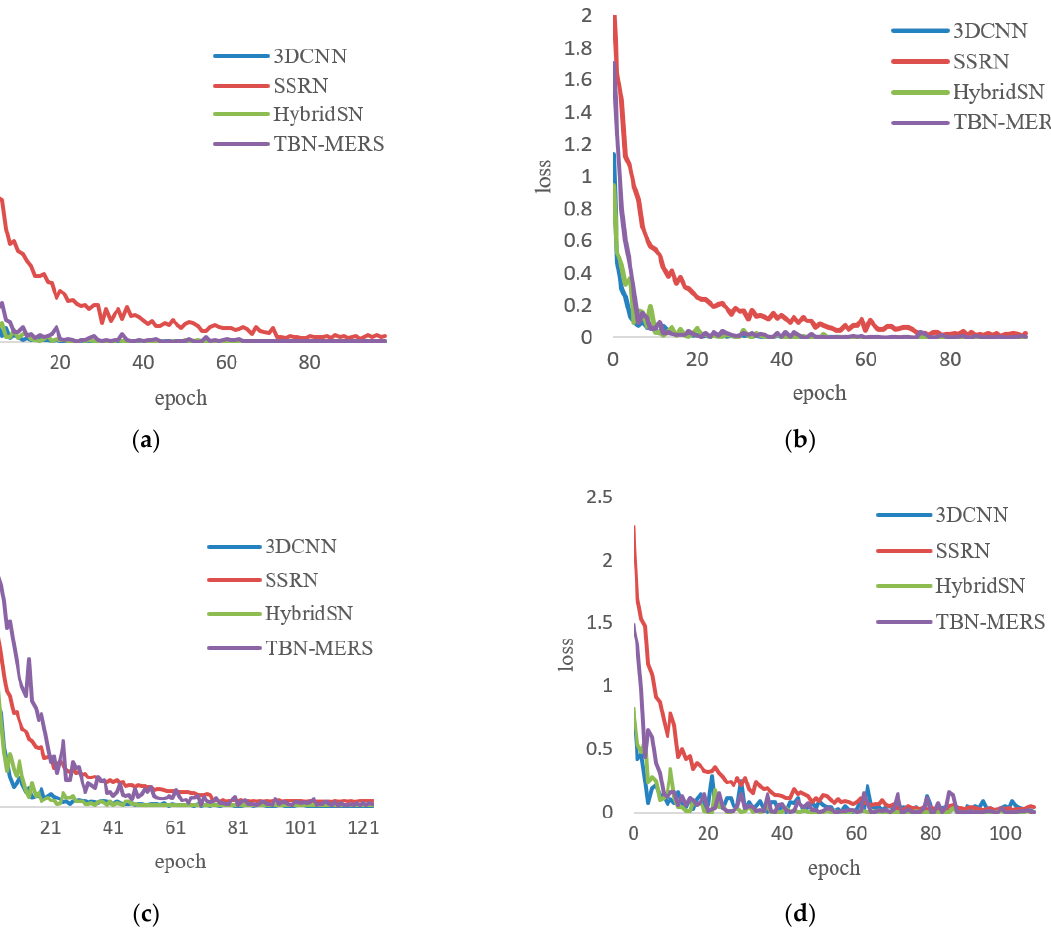
Figure 13. Training loss curves of four deep learning methods on different datasets: ( a ) IP, ( b ) PU, ( c ) SA, and ( d ) Table 14. Time for deep learning methods on different datasets.